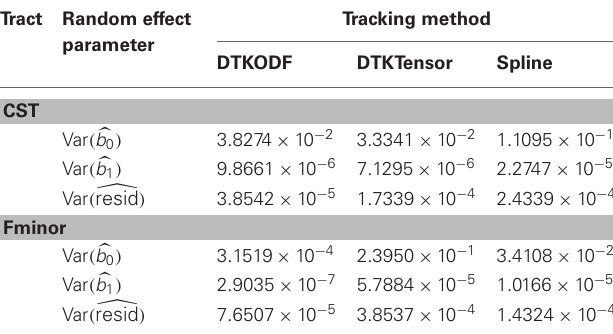
Table 4 | CST and Fminor —Tracking-dependent random effects estimates in (7) using lmer() .